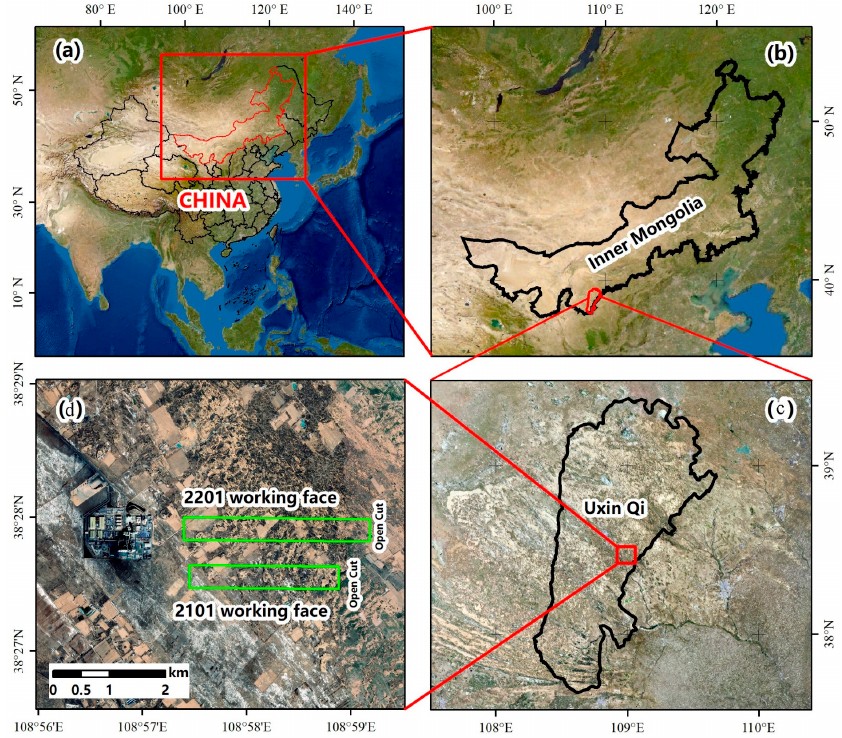
Figure 1. Location of the study area. ( a ) China. ( b ) Inner Mongolia. ( c ) Uxin Qi. ( d ) Working face.